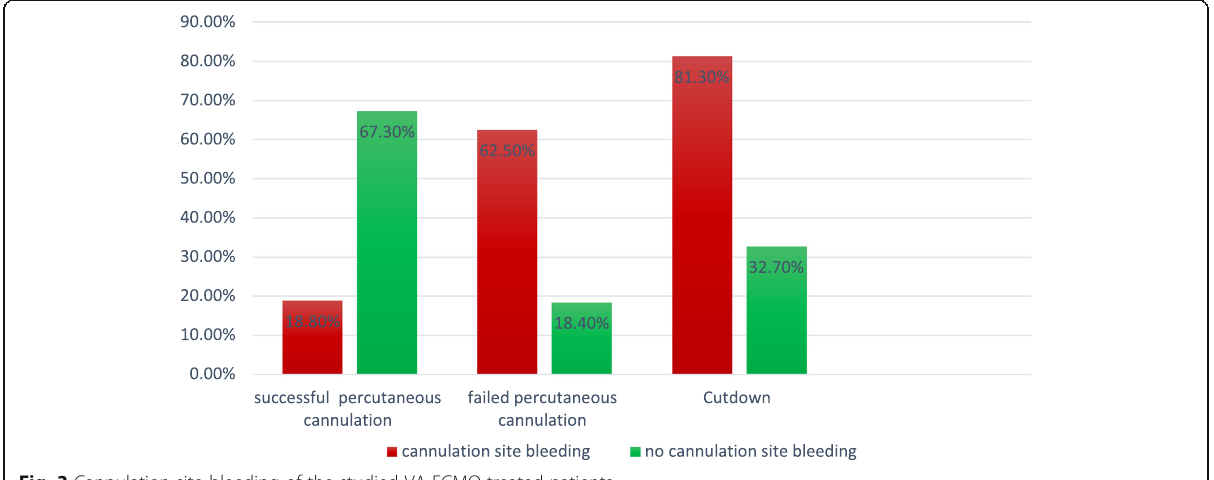
Fig. 3 Cannulation site bleeding of the studied VA-ECMO-treated